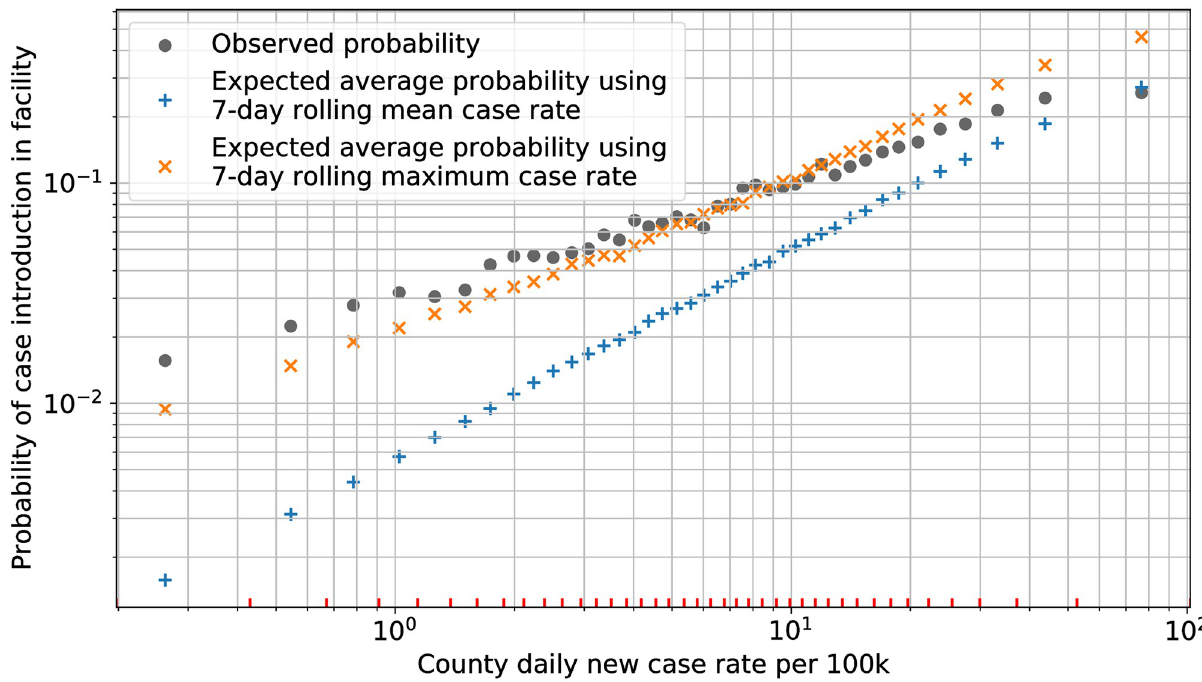
Fig 2. Probability of COVID-19 case introduction. Comparison of observed and expected probability of COVID-19 cases getting introduced in nursing homes based on the county-level case rates. Observations include all weeks prior to and including when the case introduction was reported in each facility. The red ticks on the x-axis mark the 7-day mean case-rate boundaries of each category bin.